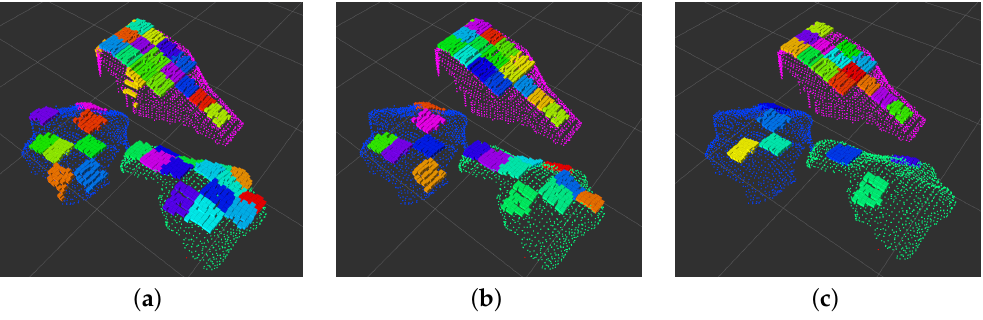
Figure 11. Results obtained after applying Rule 2 using different curvature thresholds. ( a ) Curvature tolerance = 0.02. ( b ) Curvature tolerance = 0.01 (used by the system). ( c ) Curvature tolerance =